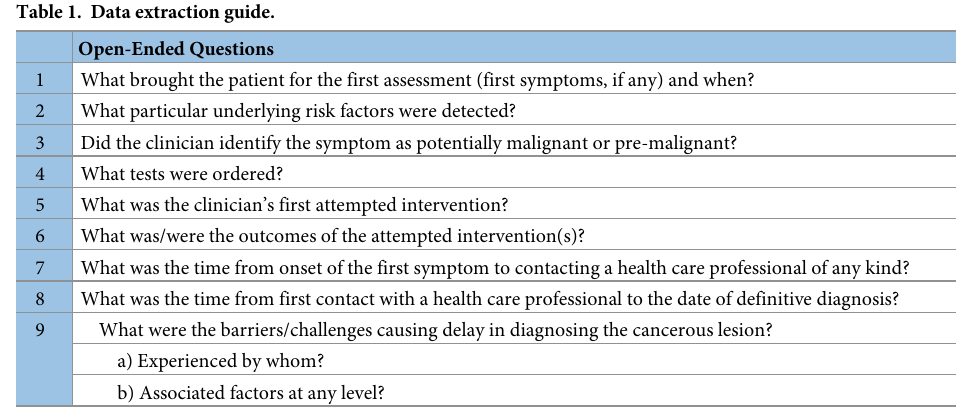
Table 1. Data extraction